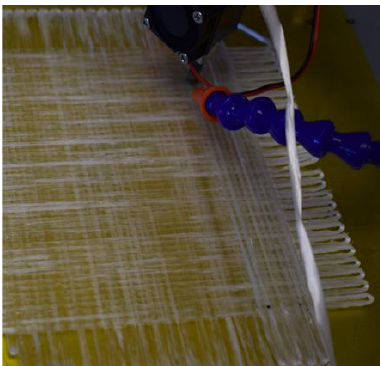
Figure 6. Manufacturing the second lamina of a Bottom Facesheet